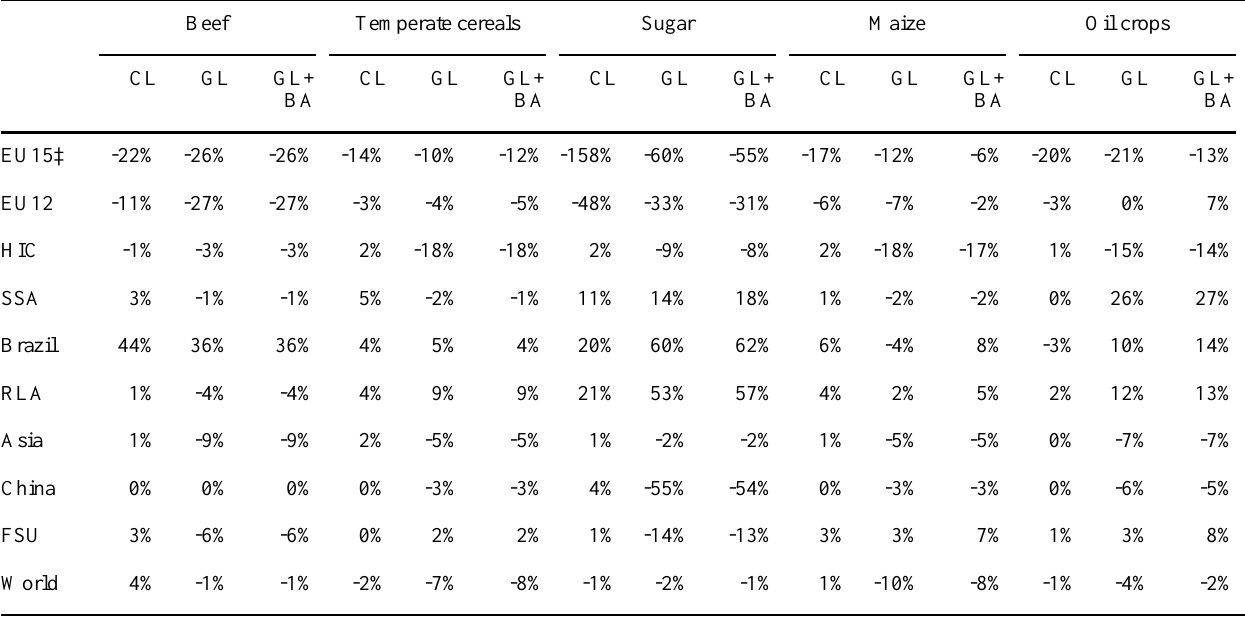
Table 4 . Changes in the production of beef, temperate cereals, sugar, maize, and oil crops in the CAP† Liberalization scenario (CL), the Global Liberalization scenario (GL), and the Biofuel Ambition scenario (GL+BA) relative to the Baseline. Beef Temperate cereals Sugar